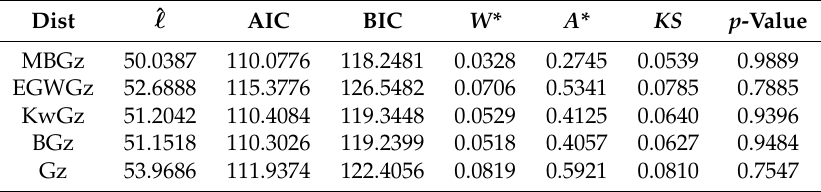
Table 4. The AIC, BIC, W* , A* , KS , and p -Value values for Dataset 1.